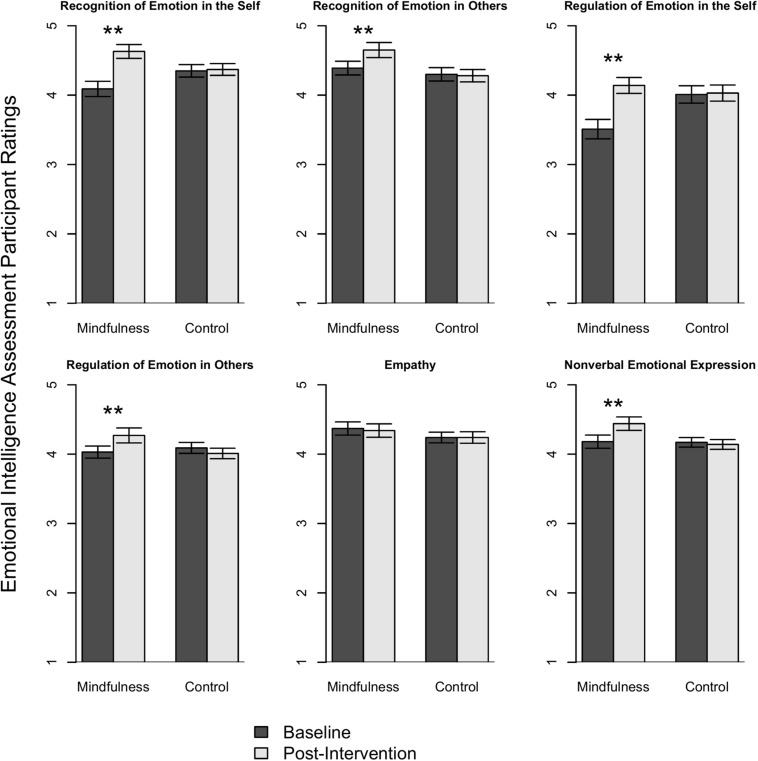
Emotional intelligence ratings. **p < 0.01.